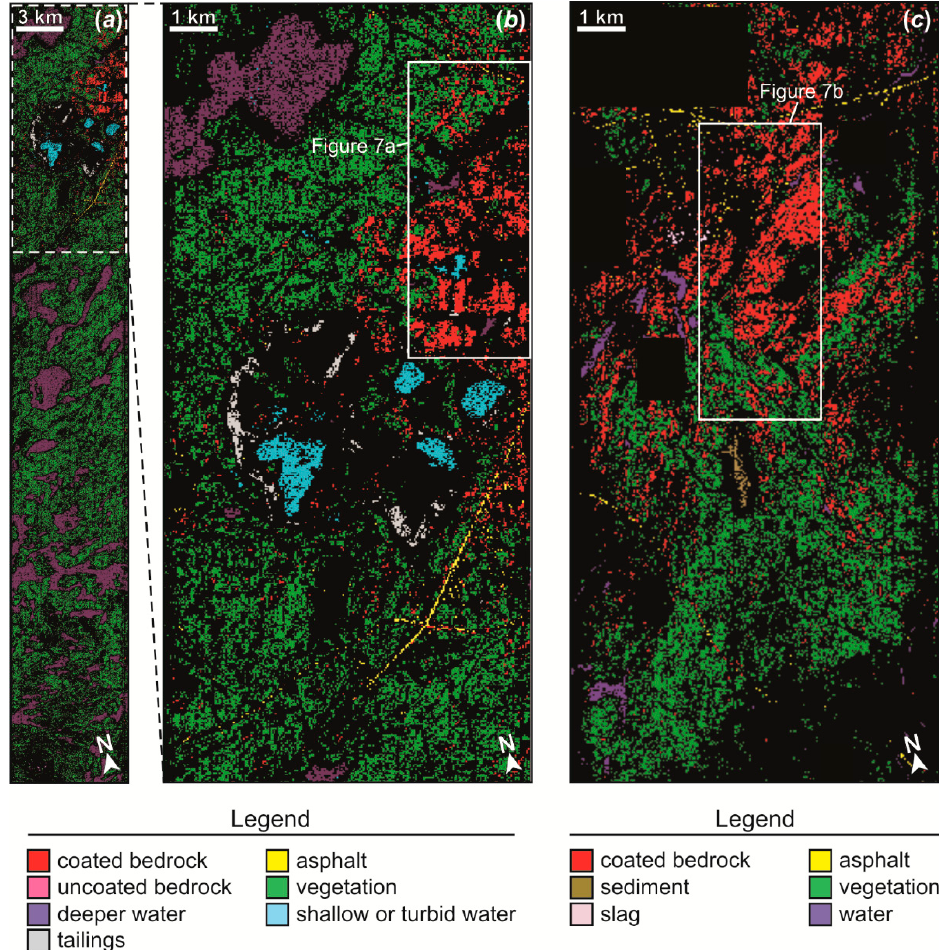
Figure 12. Maps of black coatings and other classes of interest for areas near the Copper Cliff ( a , b ) and Coniston ( c ) smelters, based on maximum likelihood classification (with null class) of the nine-channel multispectral databases generated from Hyperion images. The null class is depicted in black. Areas affected by cloud cover in the Coniston study area are masked by black rectangles. Image footprints and smelter stack locations are given in Figure 1. Selected lakes and other landmarks are labeled in Figures 6 and 7.